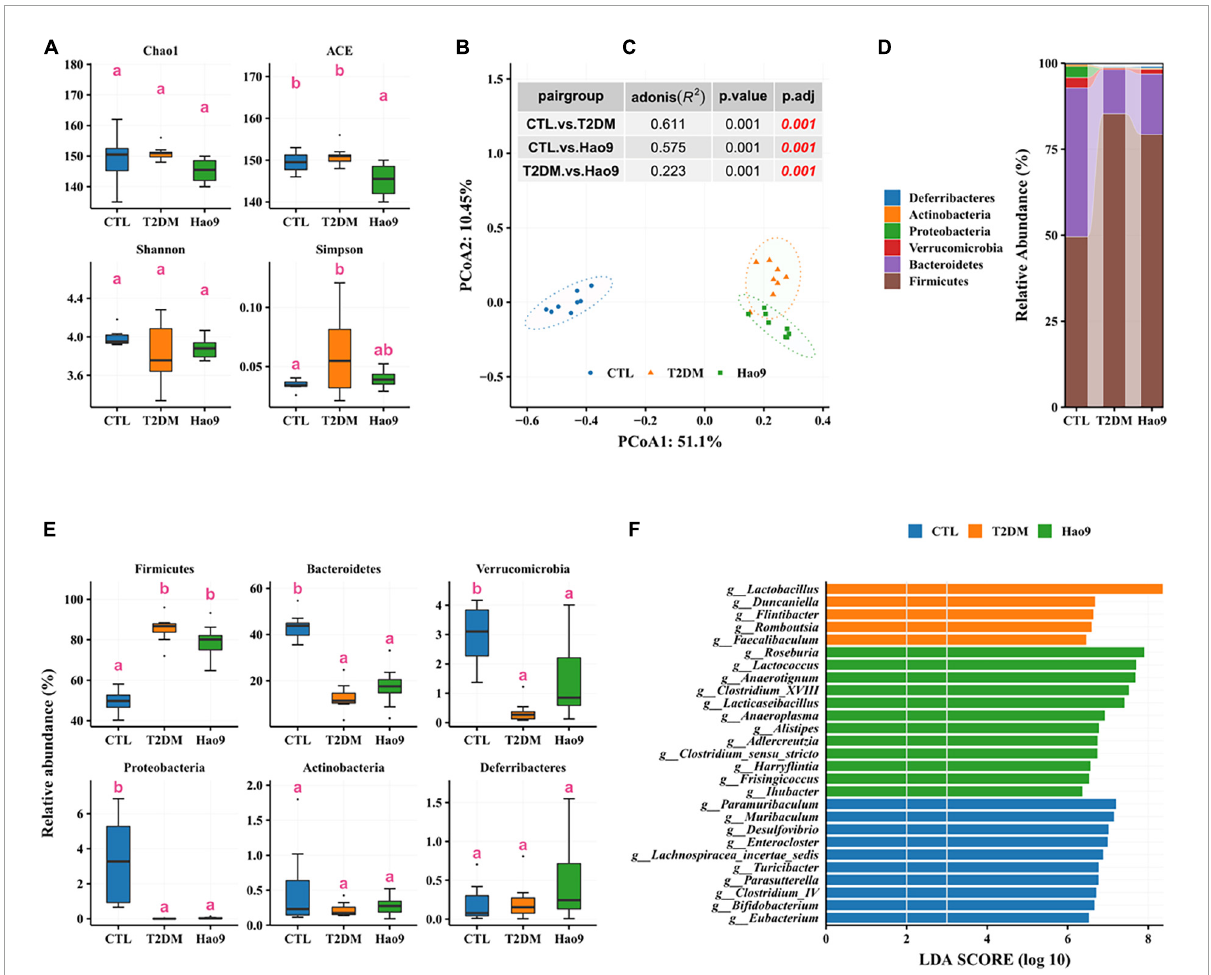
FIGURE4 Effect of Hao9 on gut microbiota in type 2 diabetes mellitus (T2DM) mice after streptozotocin injection (week 5). Alpha diversity of gut microbiota in mice (A) . Principal coordinate analysis (PCoA) of gut microbiota based on Bray–Curtis distances (B) ; table (C) in the figure shows the results of the adonis analysis between pair groups. Relative abundance of gut microbiota at phylum level (D,E) . Linear discriminant analysis effect size (LEfSe) was used to analyze the relative abundance (F) of gut microbiota at the genus level. Different superscript letters were statistically significantly different ( p <